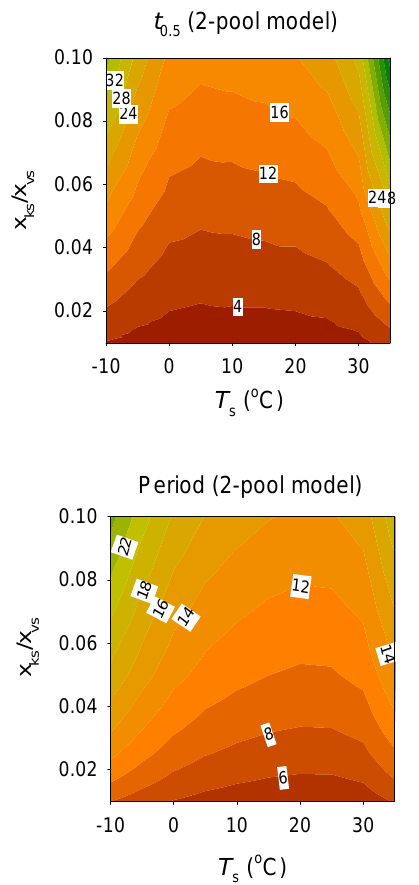
Fig. 5. Variation of t 0 . 5 with x ks / x vs and T s (upper panel) and pe- Figure 5. Variation of half time ( t riod of oscillation with x ks / x vs and T s (lower panel) in the two-pool model. The unit is year for both t 0 . 5 and period. oscillation with x period. 795